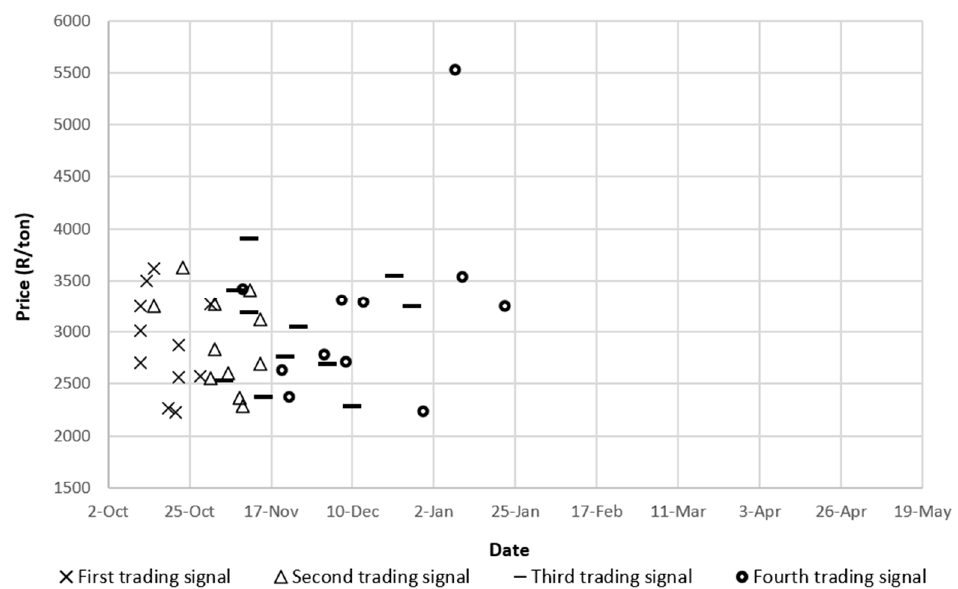
Figure 3. Timing of sales during the 11 marketing years for a risk-averse decision-maker using the MAC 9-1 marketing strategy. Source: Author’s compilation. 1500200025003000350040004500500055006000 Figure 4. Timing of sales during the 11 marketing years for a risk-neutral decision maker using the MAC 26-6 marketing strategy. Source: Author’s compilation. Figure 4 shows that a risk-neutral decision-maker will begin trading his maize on the 5th of November. The timing of the sales for the MAC 26-6 marketing strategy is more spaced out across the 11 marketing seasons than the MAC 9-1 pricing strategy. Since the timing of the sales of the marketing strategy is more dispersed, a distinct optimal market- ing window cannot be identified as with the MAC 9-1 strategy. Such behavior is rational for a risk-neutral decision-maker, who wants to increase the average MAMC. The historical prices show a significant increase in the maximum prices from the 17th of November. Thus, a risk-neutral decision maker will start selling later to capture the possible price increases, even though the downside risk increases from the 10th of Decem- ber to the end of the marketing year.